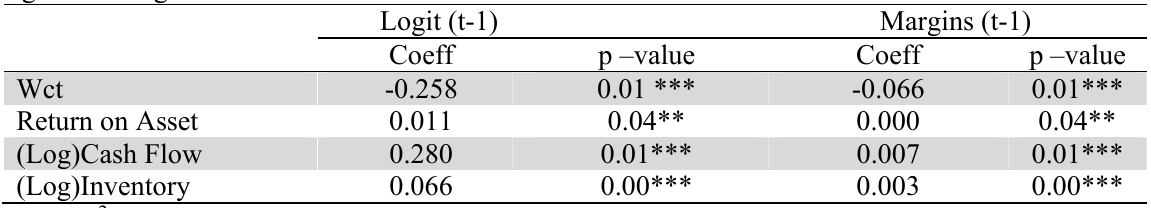
Logit and Marginal